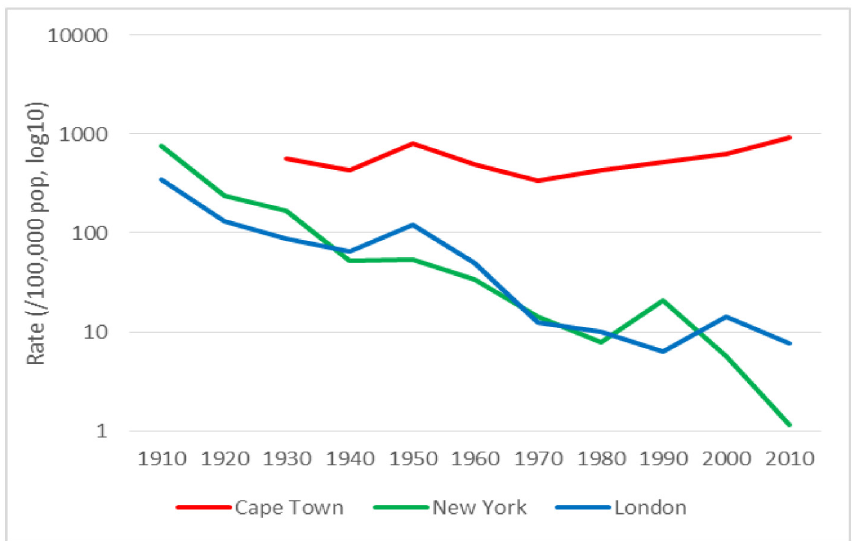
Fig 4. TB notification rates among children aged 0 – 4 years per decade over time. Note. Y-axes are on a logarithmic scale (base 10). Age-stratified rates in Cape Town were not available prior to 1930. Cape Town rates for 2002 and 2010 include TB in HIV-infected